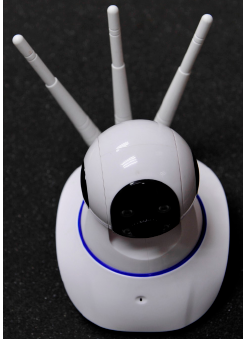
Figure 6. The Internet Protocol (IP) camera used in this study.